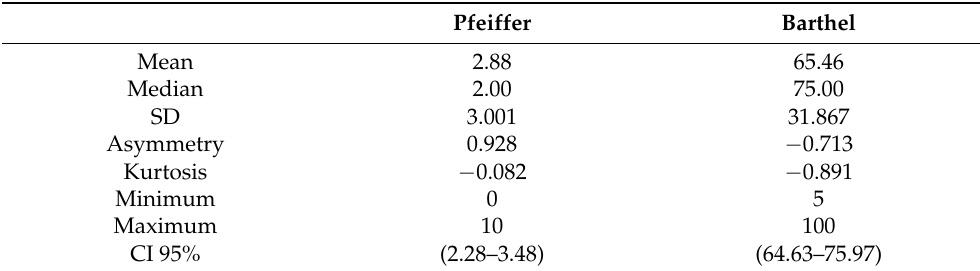
Table 1. Measures of central tendency of the Barthel and Pfeiffer. n = 109.